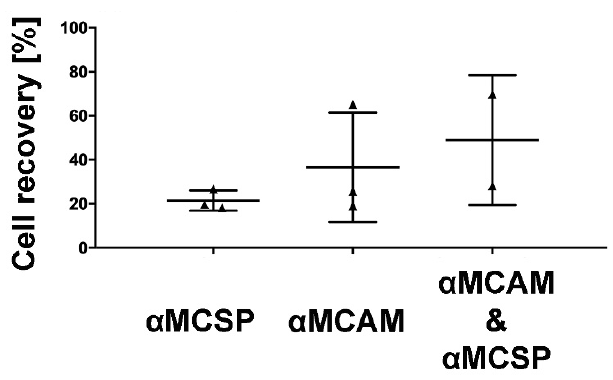
Figure 3. GBM cell capture.